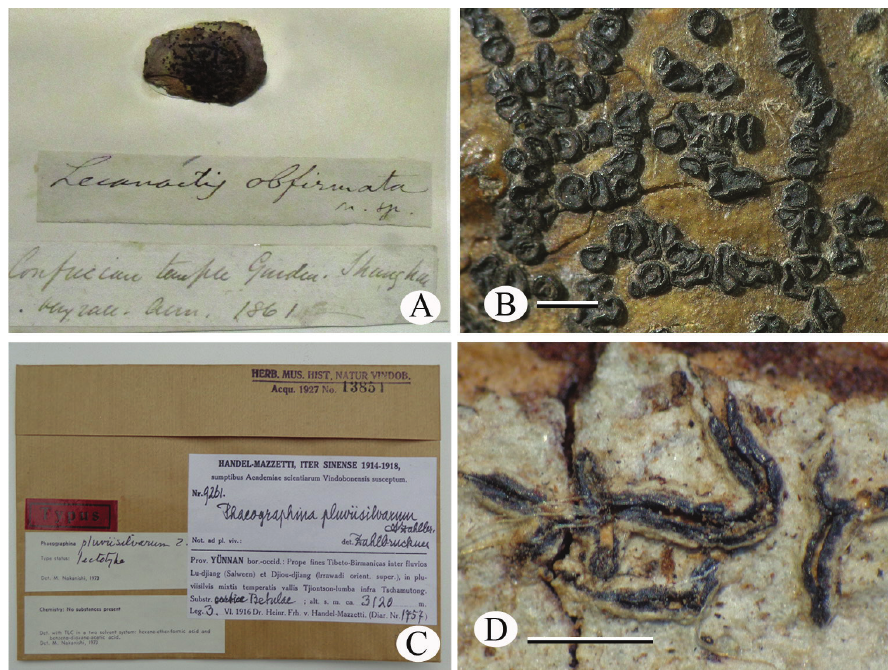
Figure 5. A–B Phaeographina obfirmata (Nyl.) Zahlbr. ( Maingay 1861 ) C–D Phaeographina pluvisilvarum Zahlbr. ( Handel-Mazzetti 9261 ). Scale bars = 1mm.